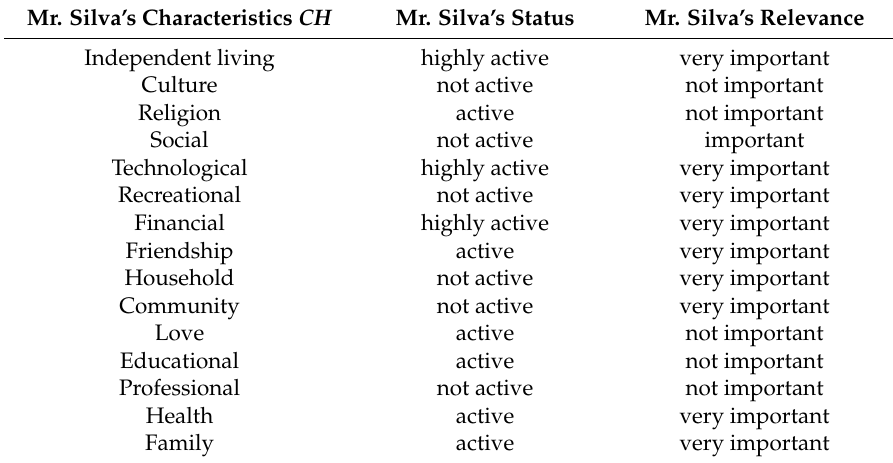
Table 5. Mr. Silva’s